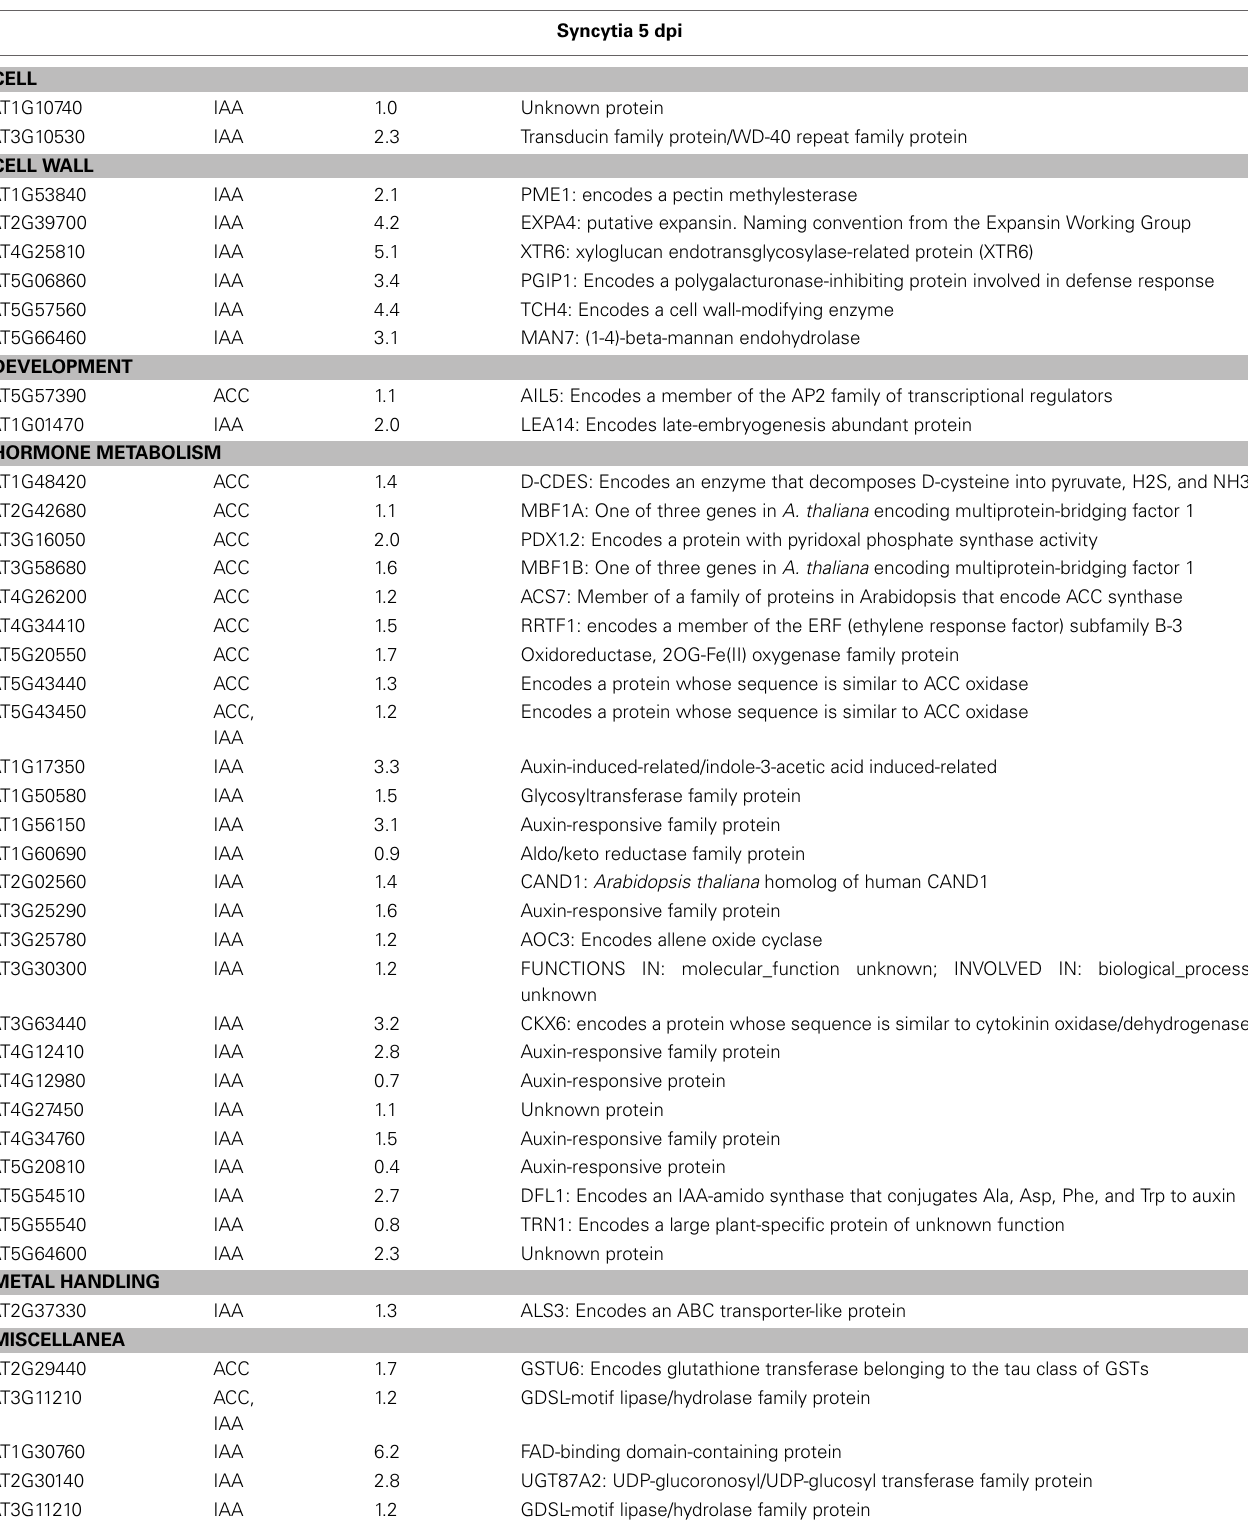
Table 1 | Genes induced in the 3 dpi GCs and 5 dpi syncytia transcriptomes (Szakasits et al., 2009; Barcala et al., 2010), that are also described to be regulated by auxin and/or ethylene in Nemhauser et al. (2006) and in Mapman (Thimm et al.,